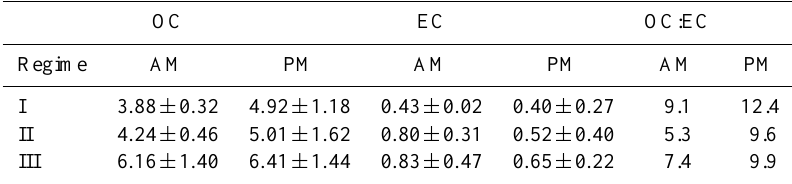
Table 3. OC/EC concentrations (µgm − 3 ) for representative days from each regime.